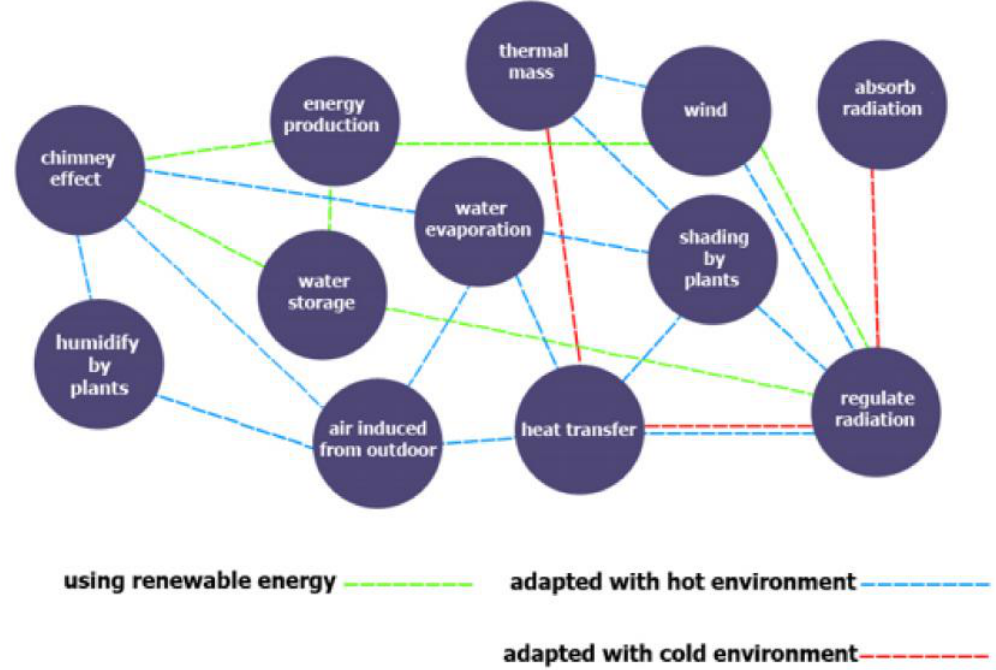
Fig. 12: functional and processual features of case